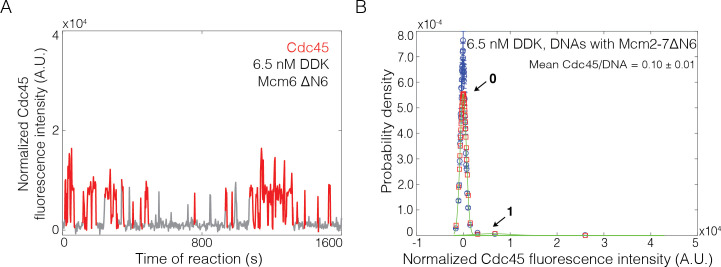
Loss of the Mcm6 N-terminal tail reduces Cdc45 binding events.(A) Representative fluorescence-intensity record for Cdc45SORT649 binding to Mcm2-74SNAP549-6ΔN-bound DNA during Cdc45-Mcm2-7-GINS formation at 6.5 nM Dbf4-dependent kinase. Points colored as in Figure 2B. (B) Binding of Cdc45SORT649 to Mcm2-74SNAP5496ΔN-bound DNA. Fit parameters and calculated area fractions of individual Gaussian components (green) corresponding to the presence of the indicated numbers of Cdc45SORT649 molecules are given in Supplementary file 1a. The mean (± SE) number of Cdc45 molecules per DNA are calculated from the fit parameters and the fraction Cdc45 labeled.